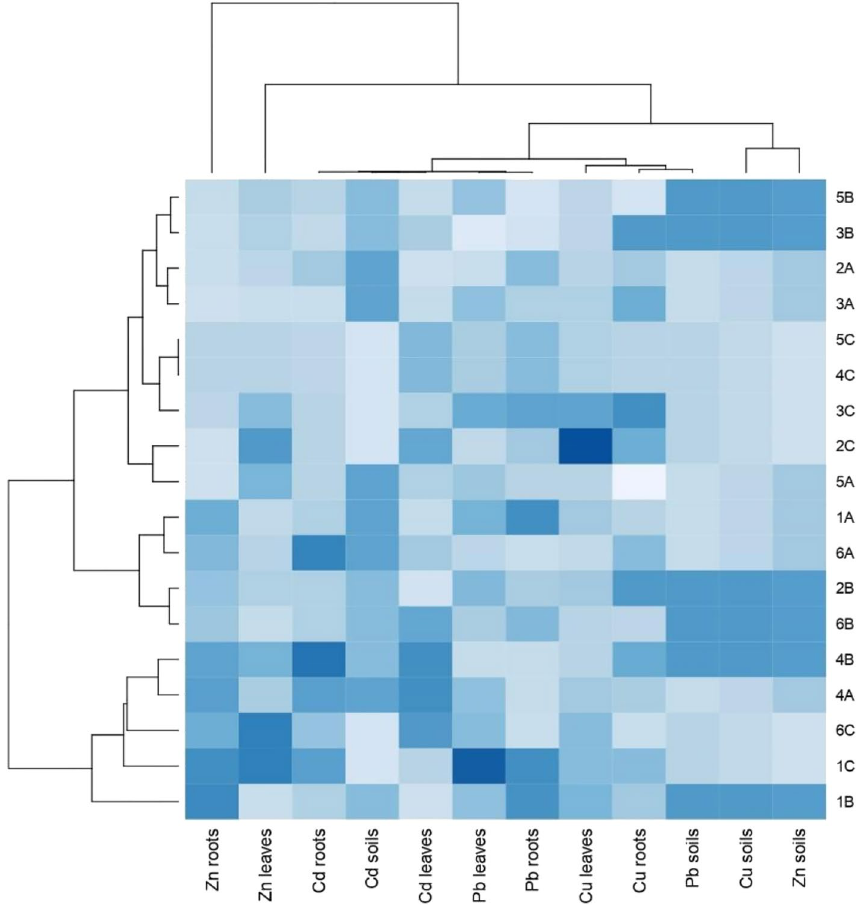
Figure 1. Heatmap and cluster analysis of heavy metal contents in soils, roots and leaves in examined samples at all research sites (abbreviations see “Materials and